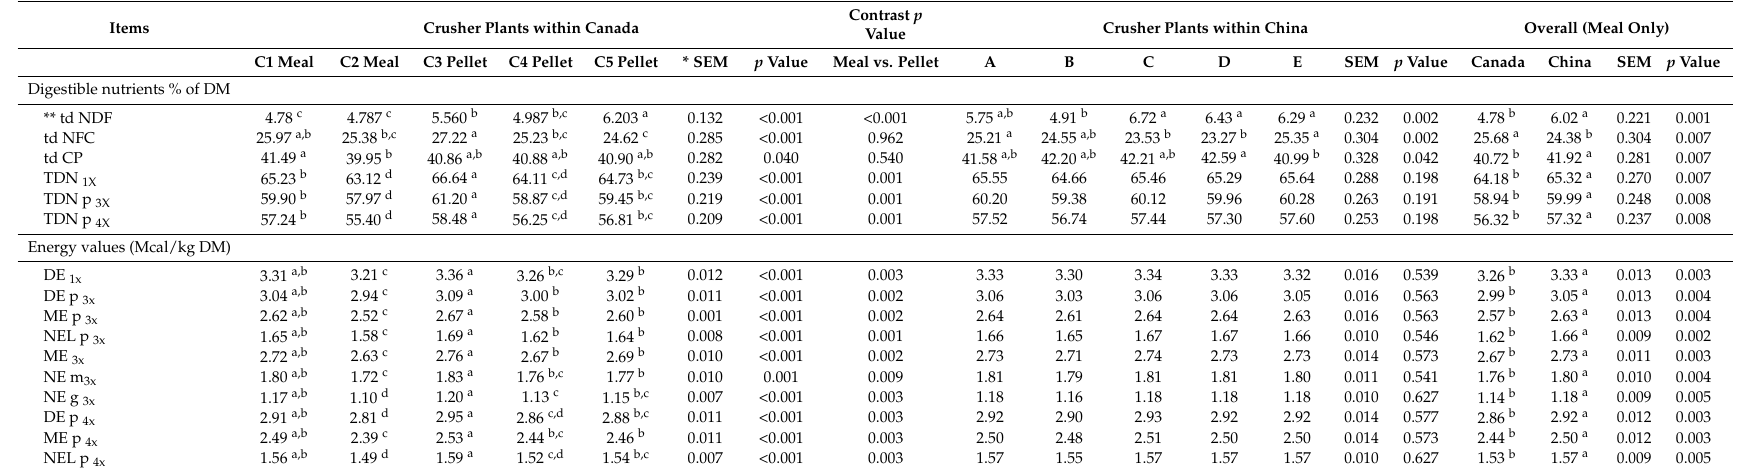
Table 4. Digestible nutrients and bioenergy values of co-products from bio-oil processing (canola meal): Comparison crusher plants within Canada and within China as well as between Canada and